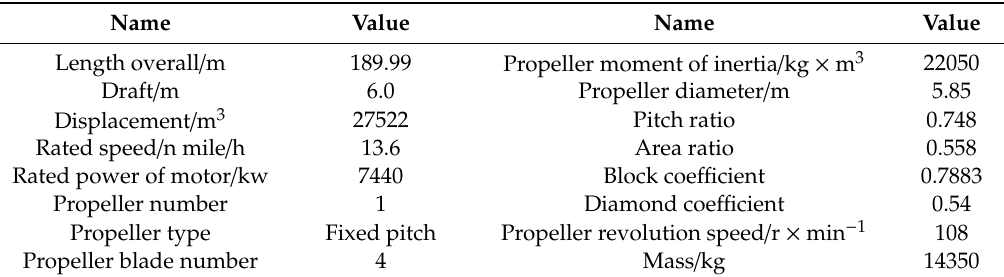
Table 5. Main principal particulars of the ship-propeller model of ship